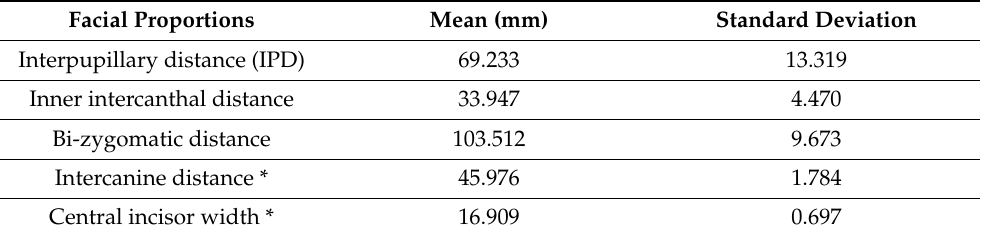
Table 6. The distribution of mean horizontal facial proportions without modification ( n = 230). Facial Proportions